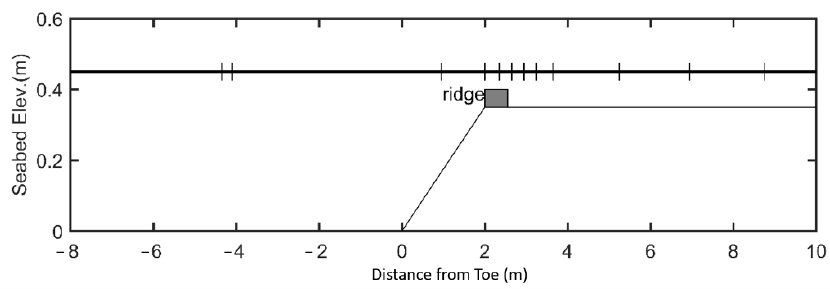
Figure 1. Cross shore profiles of reef bathymetry and wave gauge locations in Yao’s experiment .